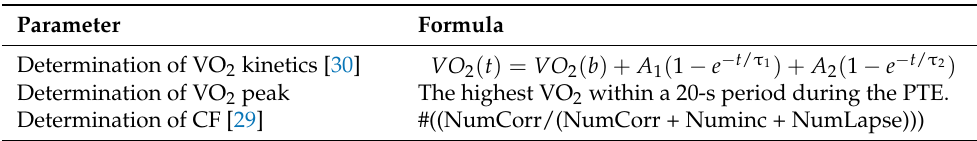
Table 1. Formulas used for determination of VO 2 parameters and CF.